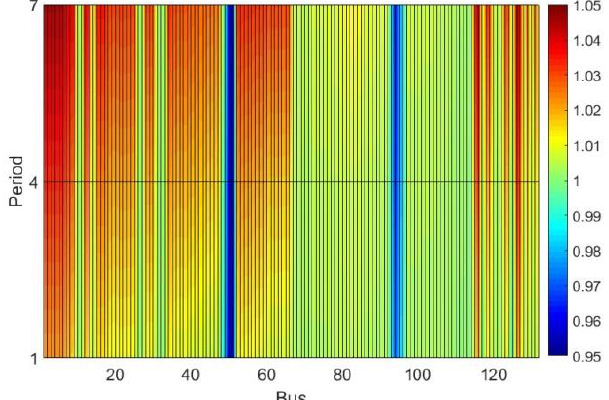
Figure 15. IEEE 123-bus system, voltage magnitudes of phase A, nominal taps, 0%